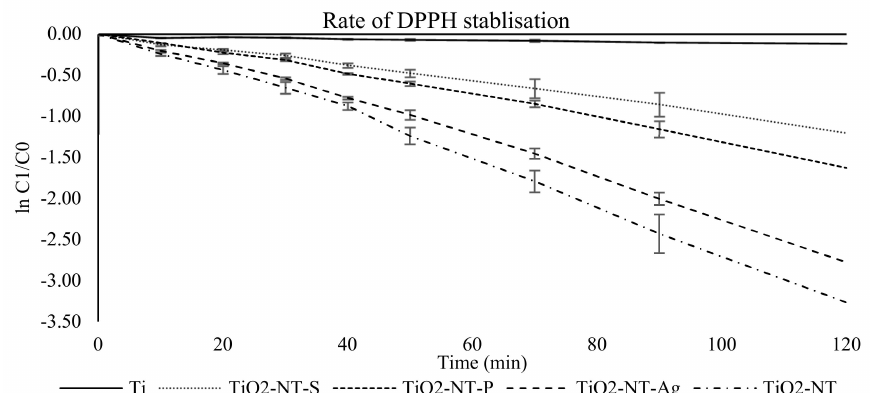
Figure 4. Rate of reaction for the stabilisation of 2,2-Diphenyl-1-picrylhydrazyl (DPPH) radicals using TiO 2 nanotube surfaces with di ff erent morphologies.